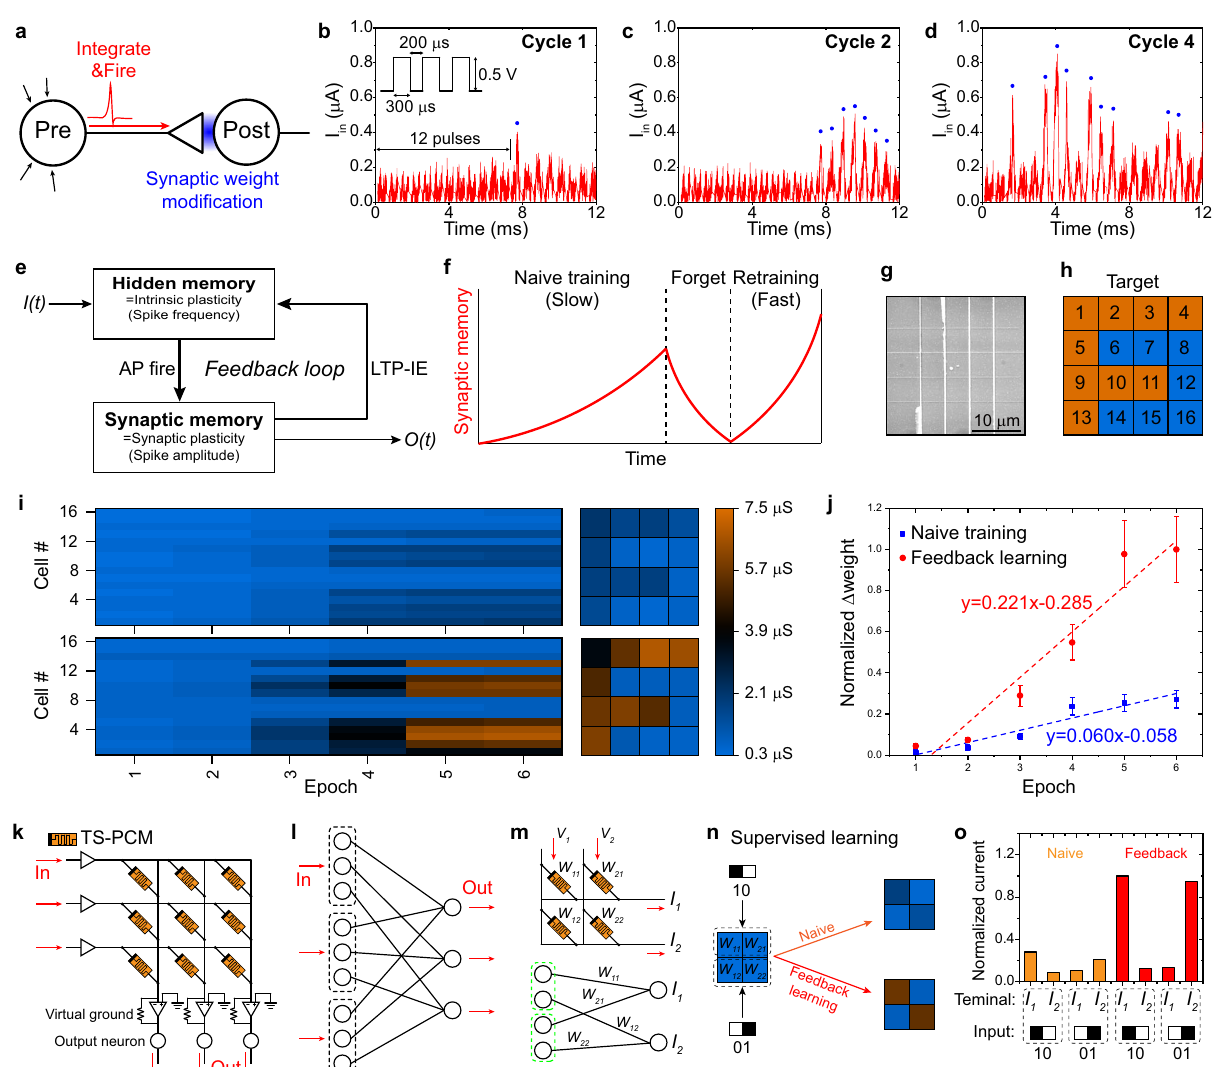
Fig. 5 Concomitant plasticity and positive feedback learning in TS-PCM. a Illustration of neuron-synapse pair structure. Input signals are integrated to fi re an AP spike modulating the synaptic strength. b – d Emulation of basic learning process using TS-PCM with the LIF model. Each cycle is consisted of 20 voltage pulses. For a repetitive input pulse trains, the number of current spikes increases along with the maximum current value, indicating the concomitant implementation of synaptic and intrinsic plasticity. Note that small peaks around 0.2 μ A are the displacement current caused by the voltage gradient, which do not represent actual movement of charges across the cell. e Schematic diagram of positive feedback learning loop based on the concomitant neuroplasticity and LTP-IE. Intrinsic plasticity and synaptic plasticity construct hidden memory and synaptic (regular) memory states, respectively. f Illustration of naive training and retraining, presenting a clear difference in the rate of acquisition. Hidden memory is developed during naive training and remains after the forget process, promoting reinforcement of the retraining process. g SEM image of crossbar structured 4 × 4 TS-PCM array. h 4 × 4 pixel image of “ F ” used in pattern memorization task in i and j . i Resistance-based color map of naive training (upper panel) and feedback learning (lower panel) for total 6 training epochs. The right panels show the resistance states of the TS-PCM array after the training process. j Normalized synaptic weight updates for two different training schemes. Each data point indicates the mean value and the error bars indicate the standard deviation. k Schematic of TS-PCM array consists of TS-PCM, post-neuron device, and peripheral circuitry. l Network structure of TS-PCM array indicating that each word line pre- neurons are subdivided according to the number of bit lines. m Schematic and network structure of 2 × 2 TS-PCM array. n Conductance level before and after the supervised training process. Two types of 2 × 1 binary patterns were trained in the array with naive and feedback training schemes. o pattern classi fi cation result in TS-PCM array. Each pattern can be recognized by the output word line current level. in the feedback loop of Fig. 5e, that results in the faster rate of Fig. 5f describes naive training, forgetting, and retraining process, acquisition. that shows a clear difference in the learning rate 4,26 . The synaptic memory state is updated by consecutive stimulation in naive The positive feedback learning is demonstrated using a TS- training, presenting relatively slow rate of acquisition compared PCM array based on the emulation of concomitant neuroplas- to retraining process. The intrinsic excitability of the neuron is ticity. As shown in the SEM image of Fig. 5g, a crossbar increased during naive training, forming the hidden memory structured 4 × 4 TS-PCM array is fabricated to conduct a pattern state that remains after the forgetting process. The retraining memorization task. A 4 × 4 pixel image of “ F ” in Fig. 5h is trained process is subsequently boosted by the hidden memory as shown in TS-PCM array using two different training schemes of naive NATURE COMMUNICATIONS| (2022) 13:2811